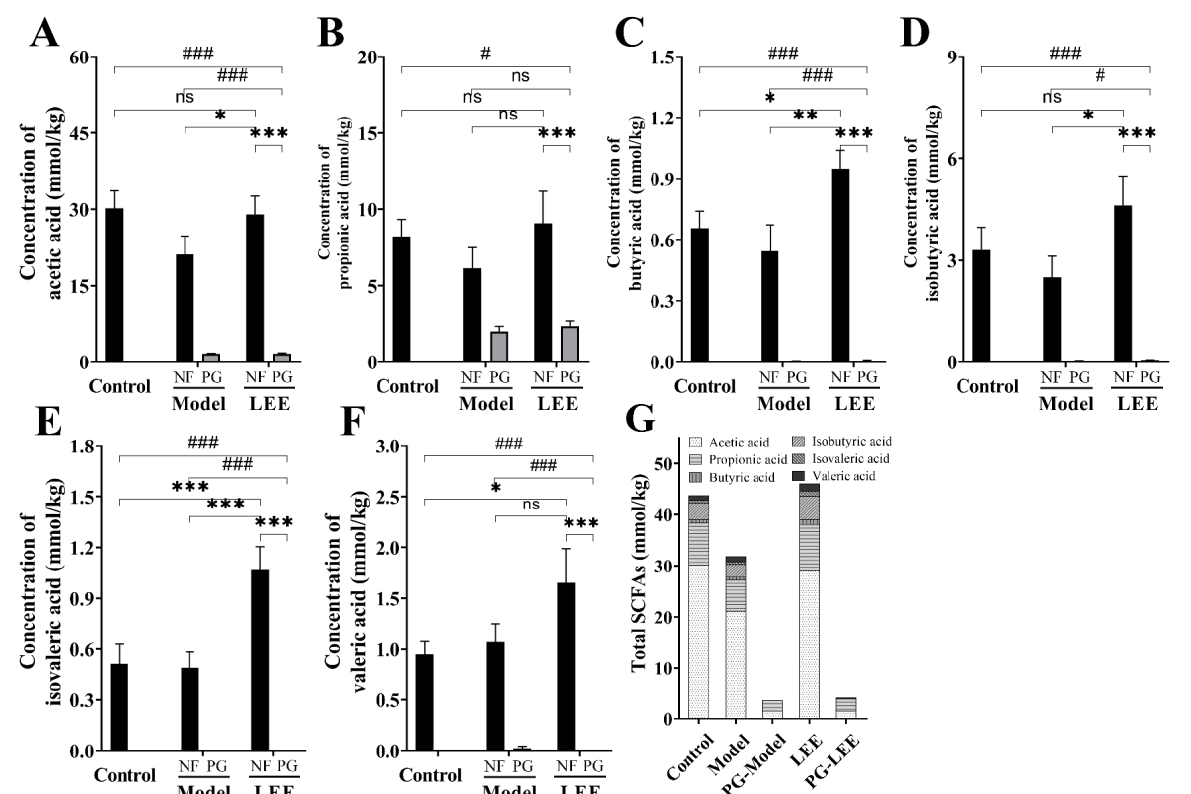
Figure 8. LEE increases the content of SCFAs in the colonic digesta of HFD mice. Determination of acetic acid ( A ), propionic acid ( B ), butyric acid ( C ), isobutyric acid ( D ), isovaleric acid ( E ), valeric acid ( F ), and total SCFA ( G ) content in the colonic digesta. Data are expressed as the mean ± SEM ( n = 6). * p < 0.05; ** p < 0.01; *** p < 0.001; # p < 0.05; ### p < 0.001; ns, not significant.